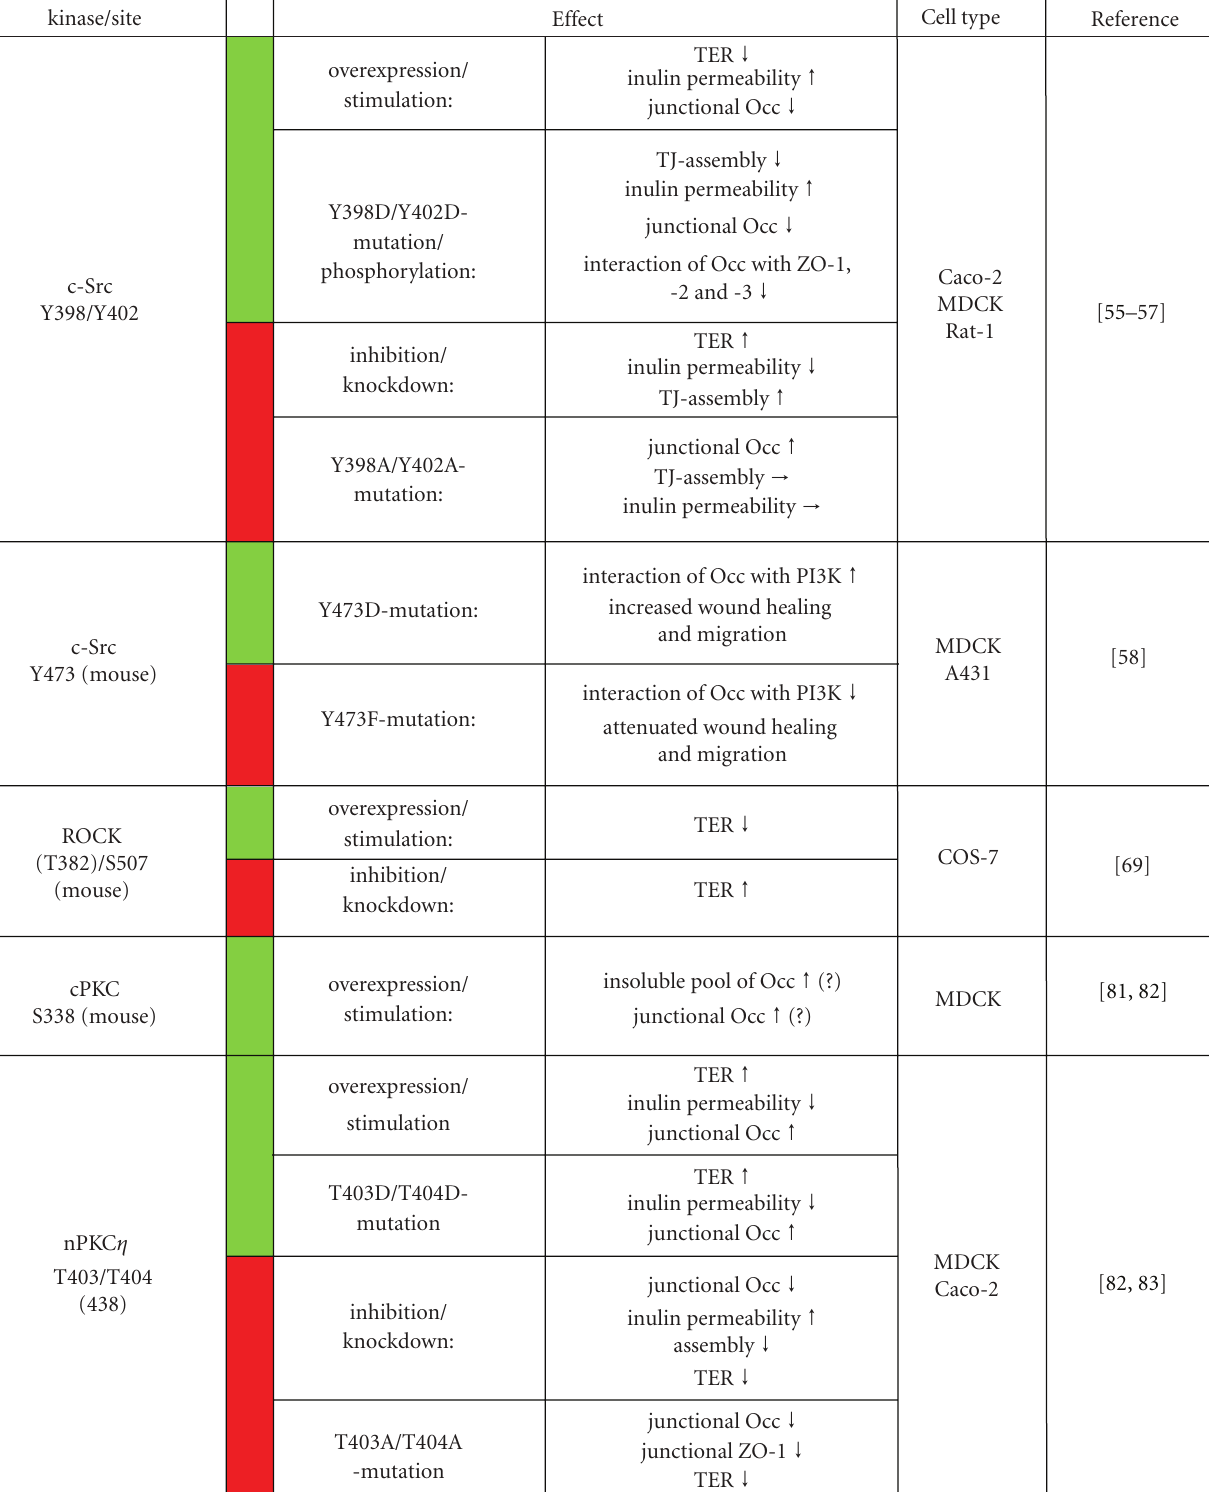
Table 1: Summary of known occludin phosphorylation sites in the context of the kinases or stimuli that induce phosphorylation at these sites and the e ff ects on TJ function generated by induced or inhibited phosphorylation. Green label: kinase overexpression, stimulation or phospho-mimetic occludin variant; red label: kinase knockdown, inhibition or occludin variant that cannot be phosphorylated at the specified amino acid